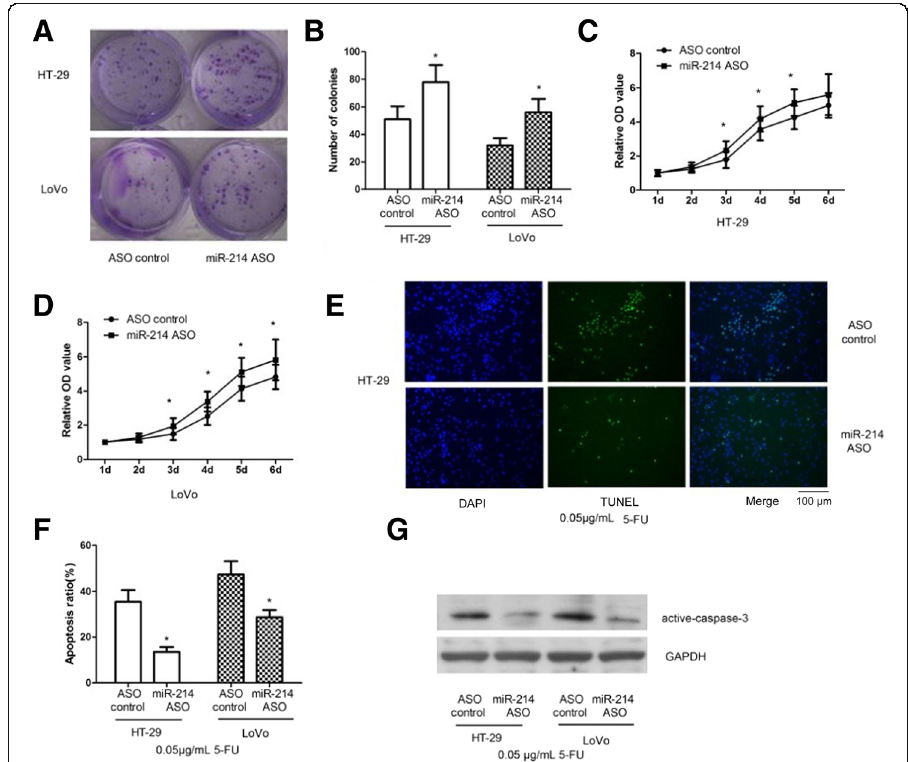
were incubated with 0.05 μ g/ml of 5-FU for 48 h. TUNEL assays were performed to detect cell apoptosis. The blue stain is the cell nucleus; green is TUNEL staining representing apoptotic cells (scale bar = 100 μ m). g – Western blots were done to detect caspase-3 protein levels. Data represent the means ± SEM from three independentexperiments. * p <